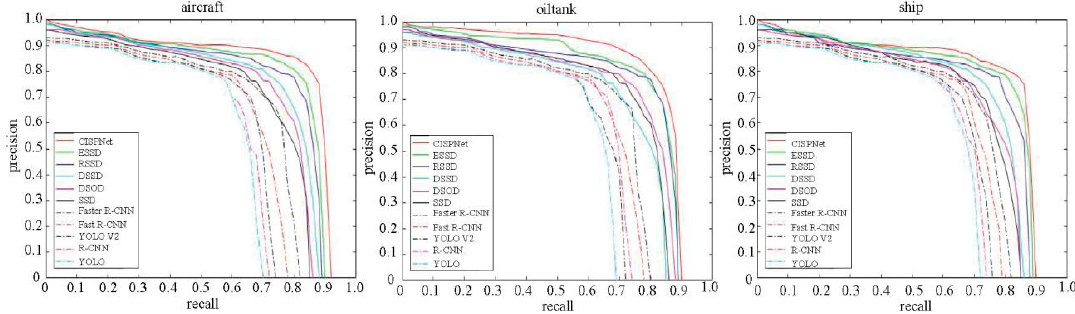
Figure 7. Precision-recall curves (PRCs) of the proposed CISPNet and other state-of-the-art approaches for airplane, ship, oiltanker,